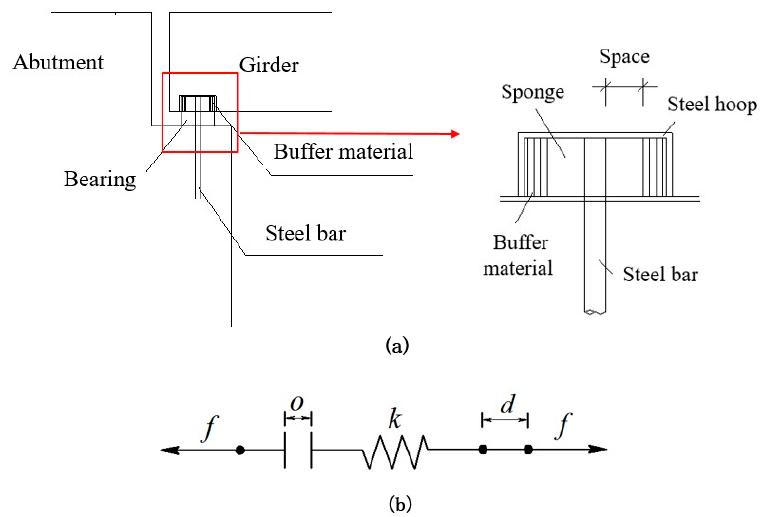
Figure 3. Structural diagram and finite element model of restrainer: ( a ) structural diagram; ( b ) finite element model.